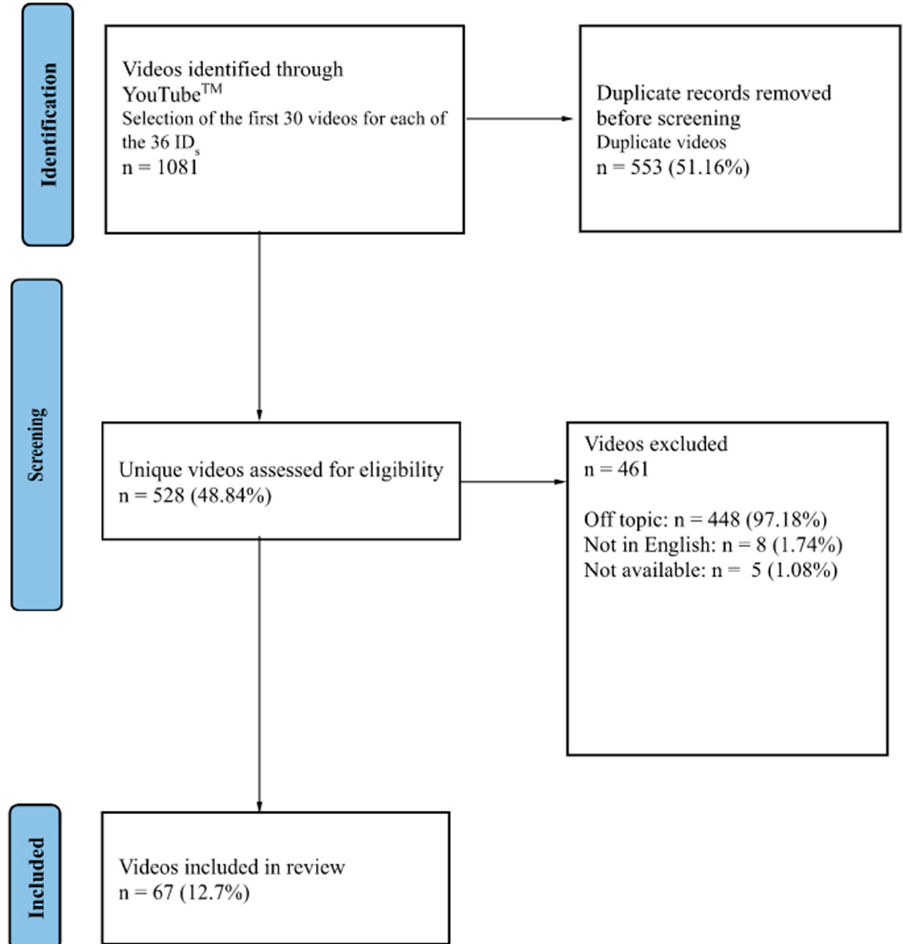
Figure 1. Prisma flow chart.